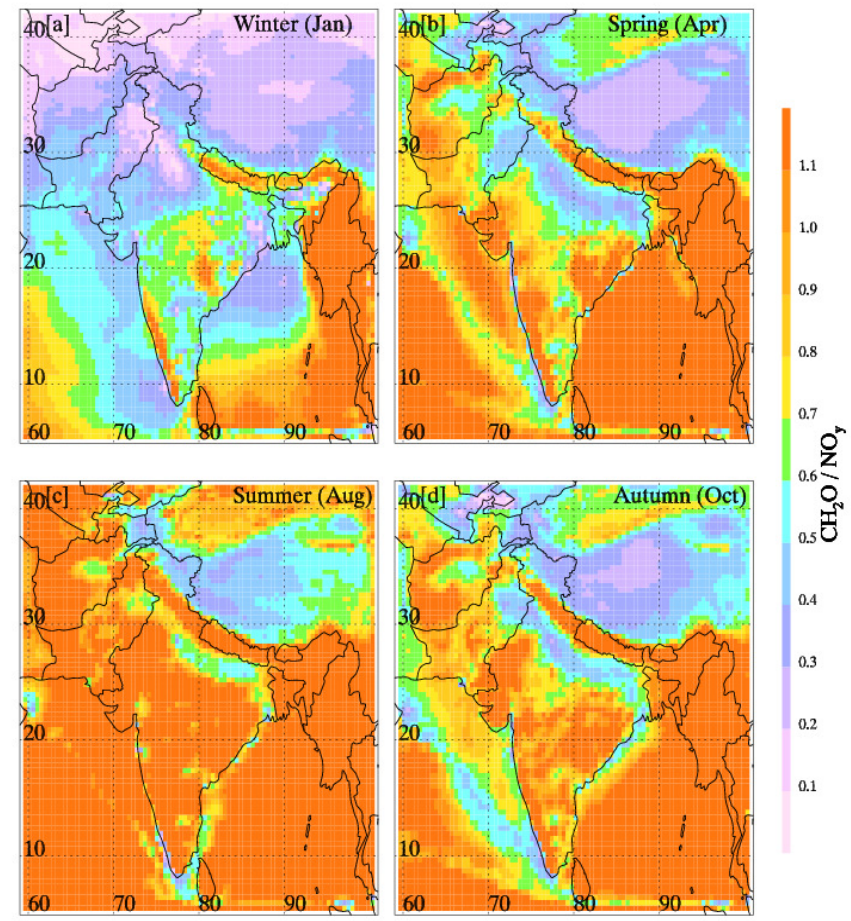
Fig. 20. Spatial distributions of WRF-Chem simulated afternoon (11:30–14:30 LT) CH 2 O to NO y ratio during January, April, August and Figure 20: Spatial distributions of WRF-Chem simulated afternoon (1130-1430 LT) CH 2 O to 1365 October of the year NO y ratio during January, April, August and October of the year 2008. 1366